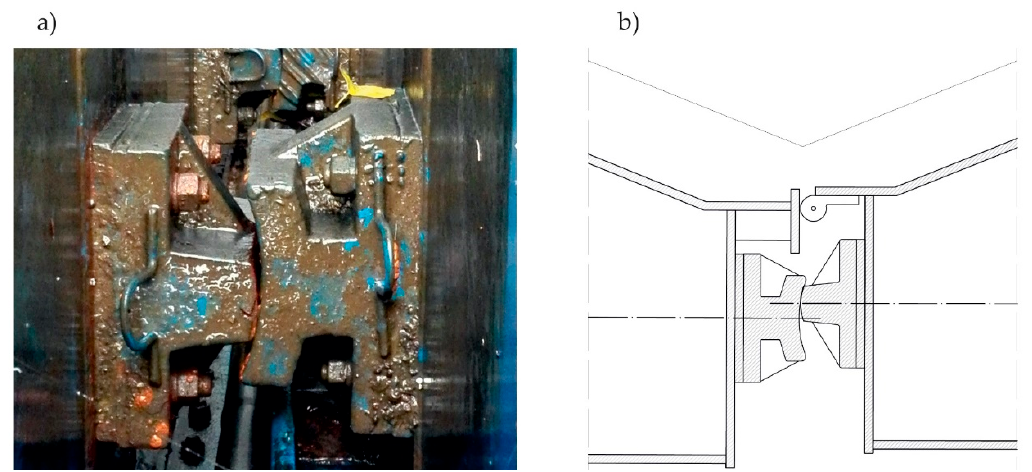
Figure 3. Observed misalignment of miter bearings. ( a ) Real view; ( b ) Scheme of the top view.